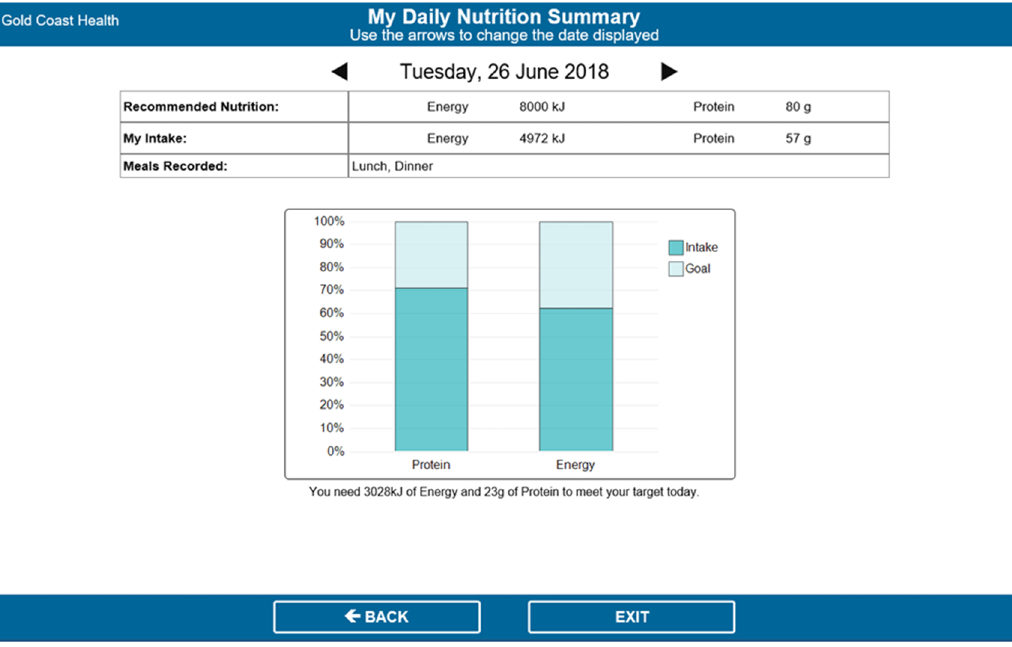
Figure 2. Nutrition goals page in the EFS.